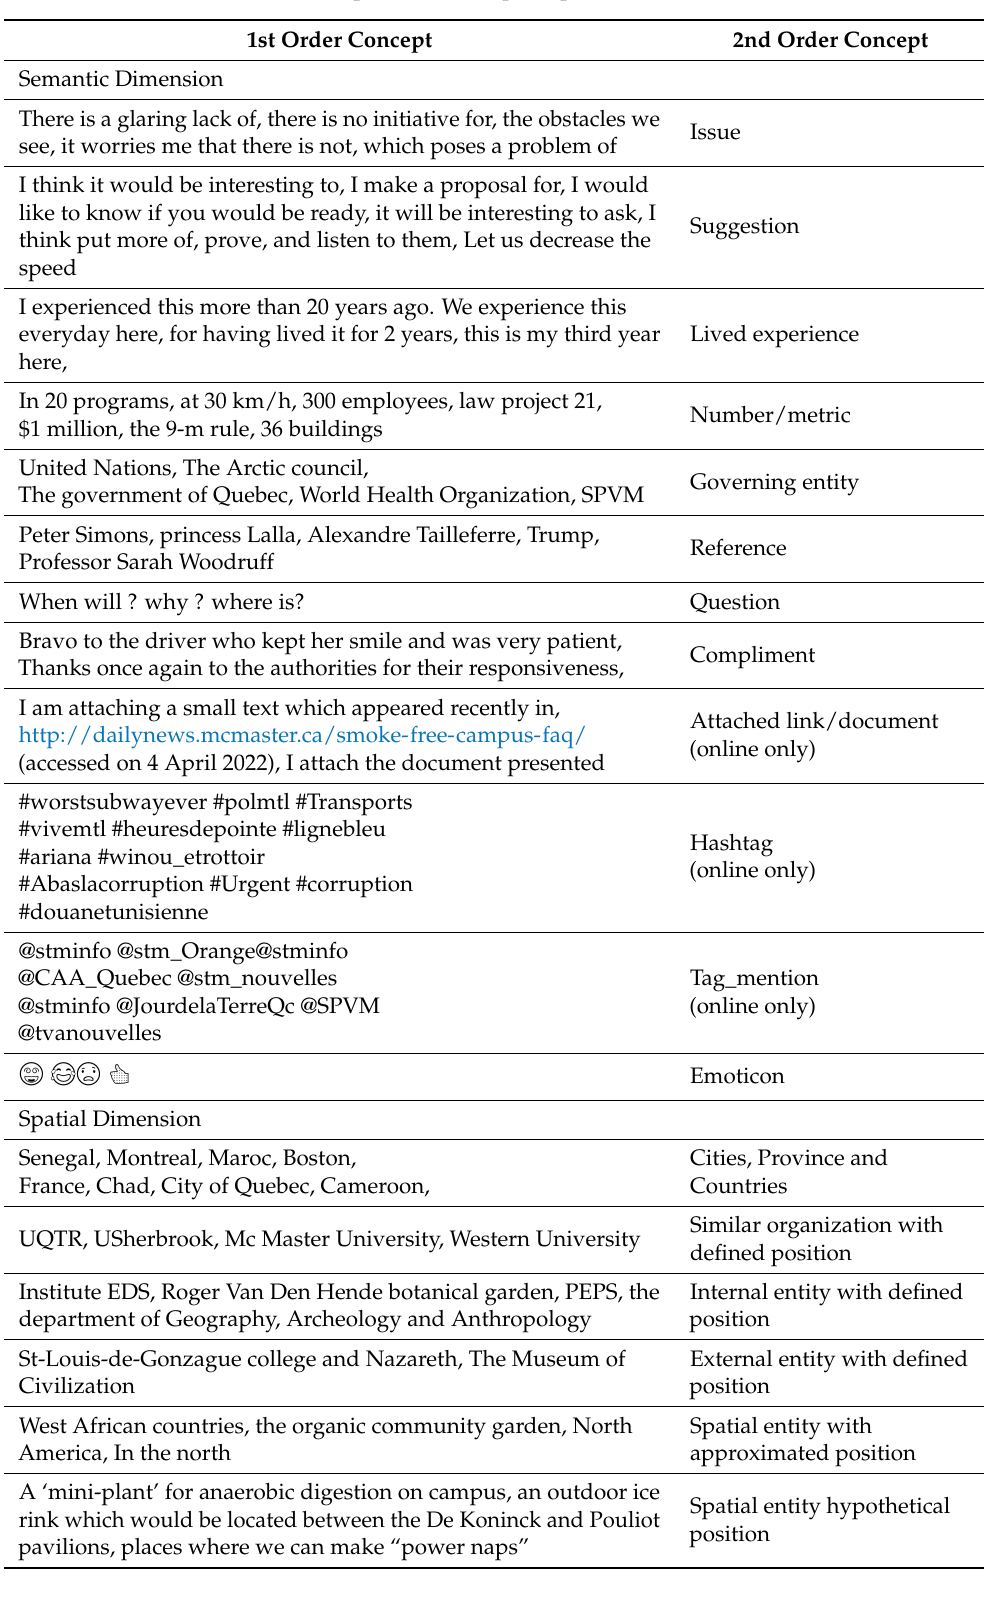
Table 1. Data structure: Semantic, spatial, and temporal patterns in SPP data.